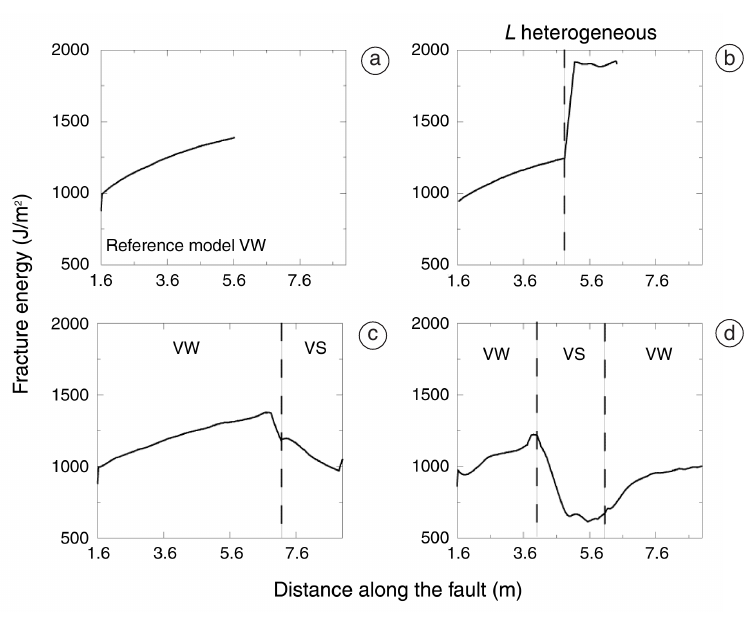
Fig. 10a-d. Fracture energy values in different positions along the fault for four configurations investigated in this study: a) refers to the reference model shown in fig. 1a-d; b) refers to the heterogeneous L distribution shown in figs. 5a,b and 6; c) and (d) refer to the heterogeneous distribution of the a and b parameters shown in figs. 8a,b and 9a,b,